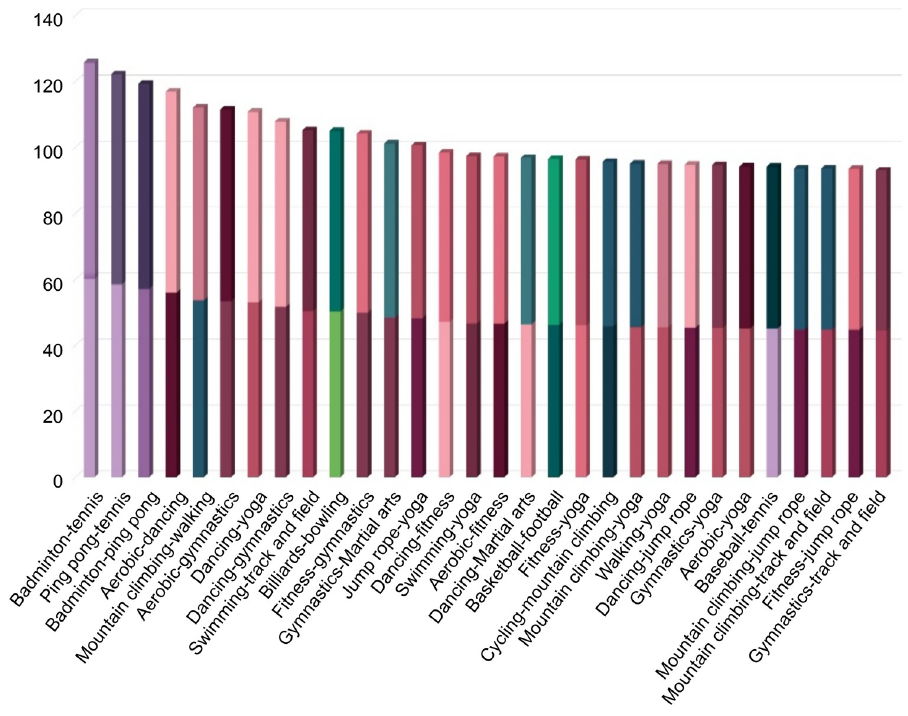
Fig 4. Sport classification—Top